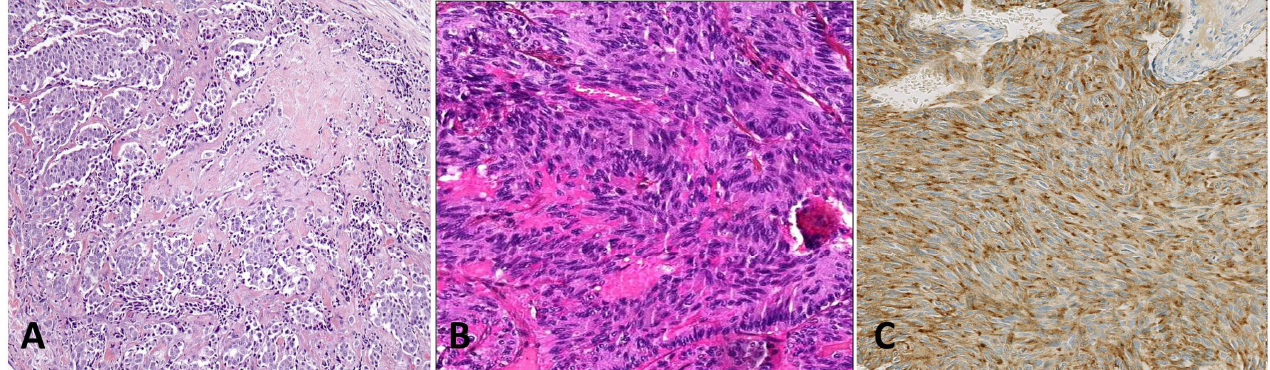
Figure 3. ( A ) MTC with amyloid stroma (×100 magnification). ( B ) MTC spindle cell variant (×400 magnification). ( C ) Calcitonin expression confirmed the diagnosis of MTC and ruled out a mesenchymal tumor (×200 magnification).